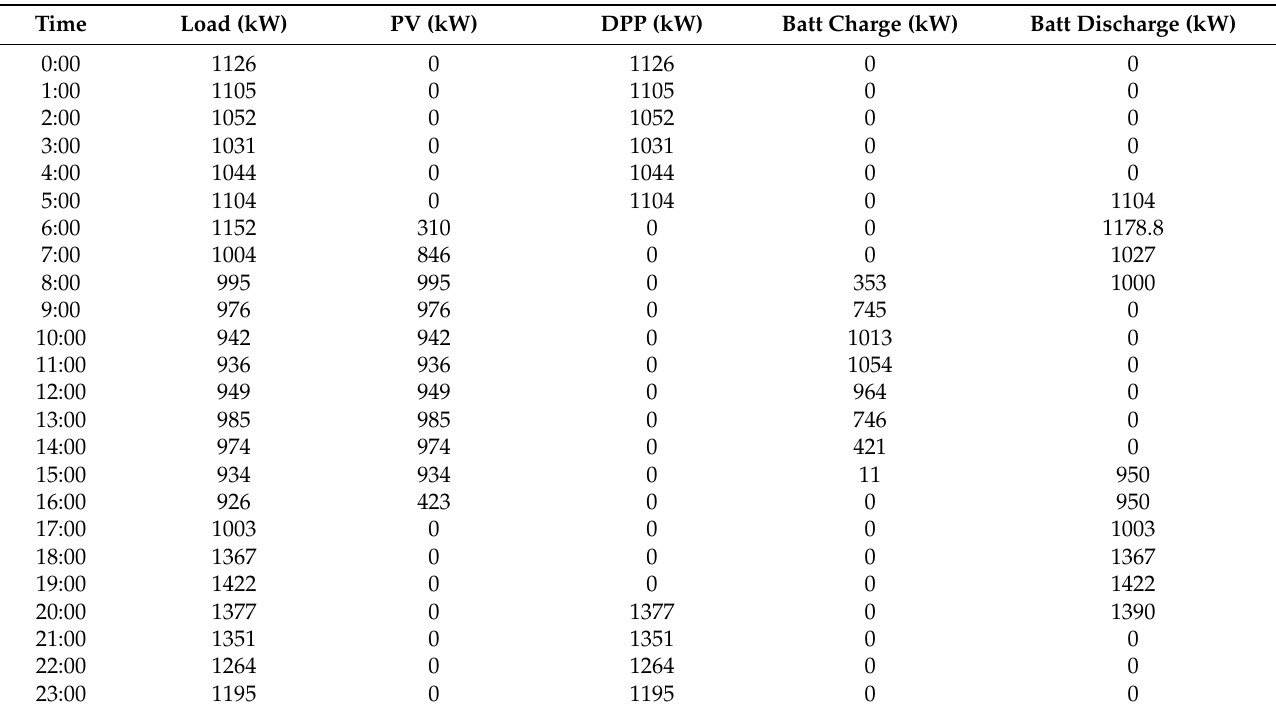
Figure 18. Hybrid system operational cycle. Table 6. Mapping hybrid operational schedule.